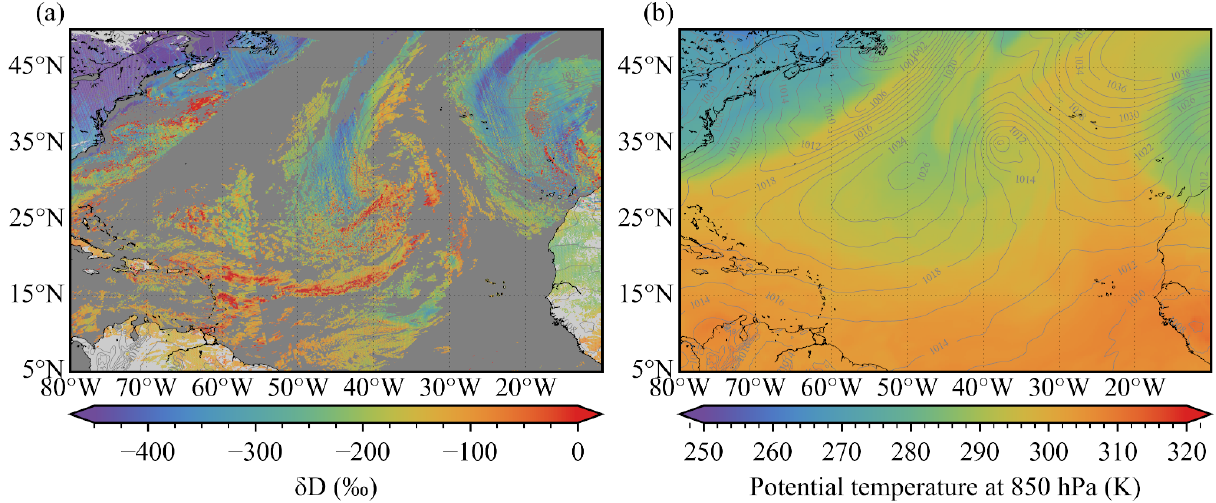
Figure 20. (a) TROPOMI single-overpass δ D and (b) ERA5 potential temperatures at 850hPa at 15:00UTC on 20 January 2020. The grey contours in all panels show ERA5 mean sea-level pressure at 15:00UTC with a contour line distance of 2hPa.